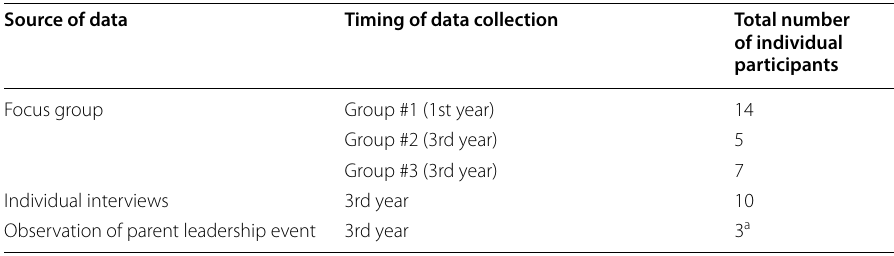
Table 1 Parent leader data